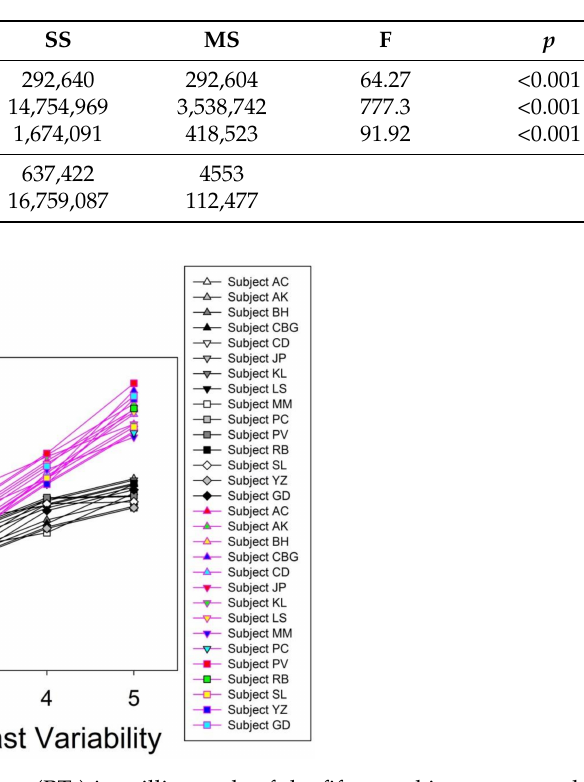
Figure 4. Individual Response Times (RTs) in milliseconds of the fifteen subjects, averaged over repeated stimuli, in the achromatic and chromatic image conditions. The longest RTs are, as could